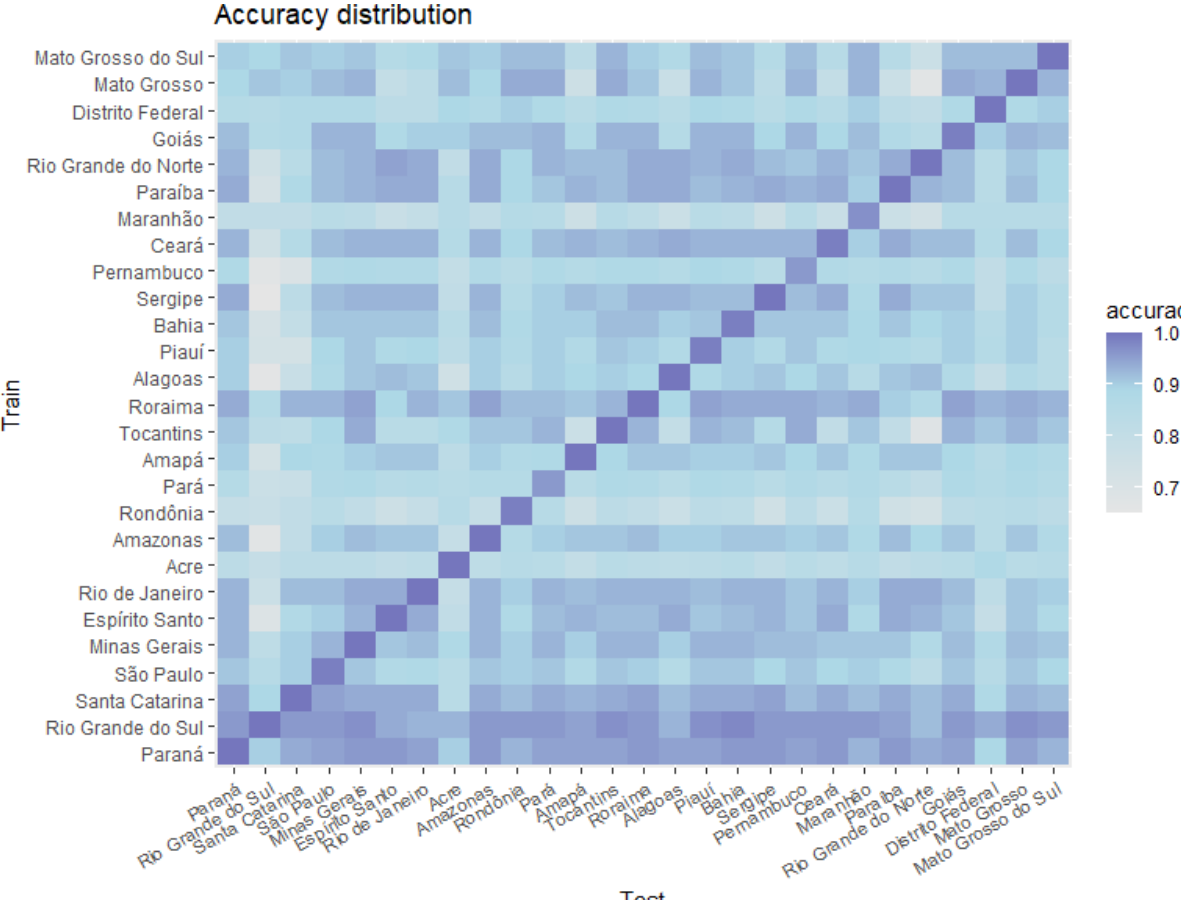
Figure 8. Quality in the classification of leprosy cases by artificial intelligence models in Brazilian states.